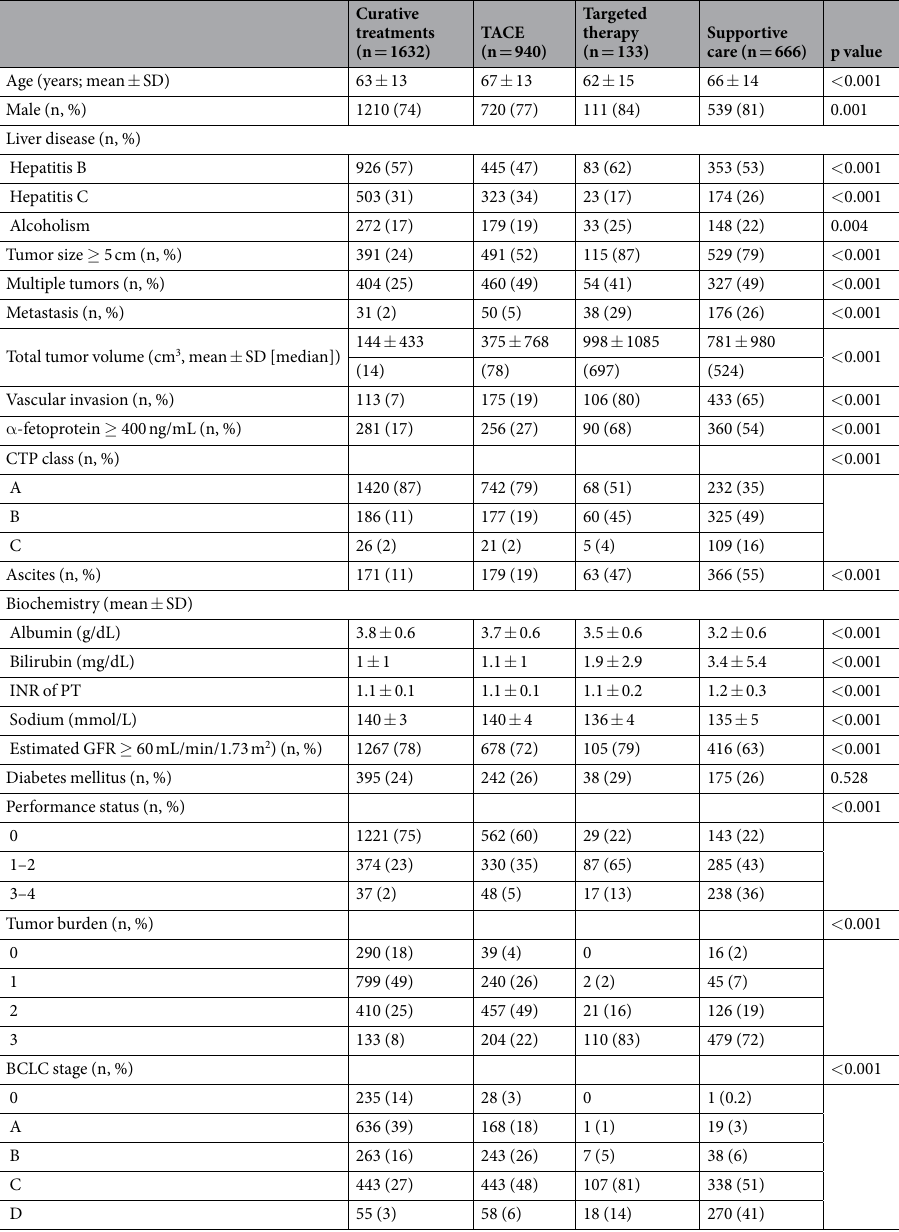
Table 2. Comparison of demographics stratified by primary anti-cancer treatments. BCLC, Barcelona Clinic Liver Cancer; CTP, Child-Turcotte-Pugh; Curative treatments include resection, ablation and